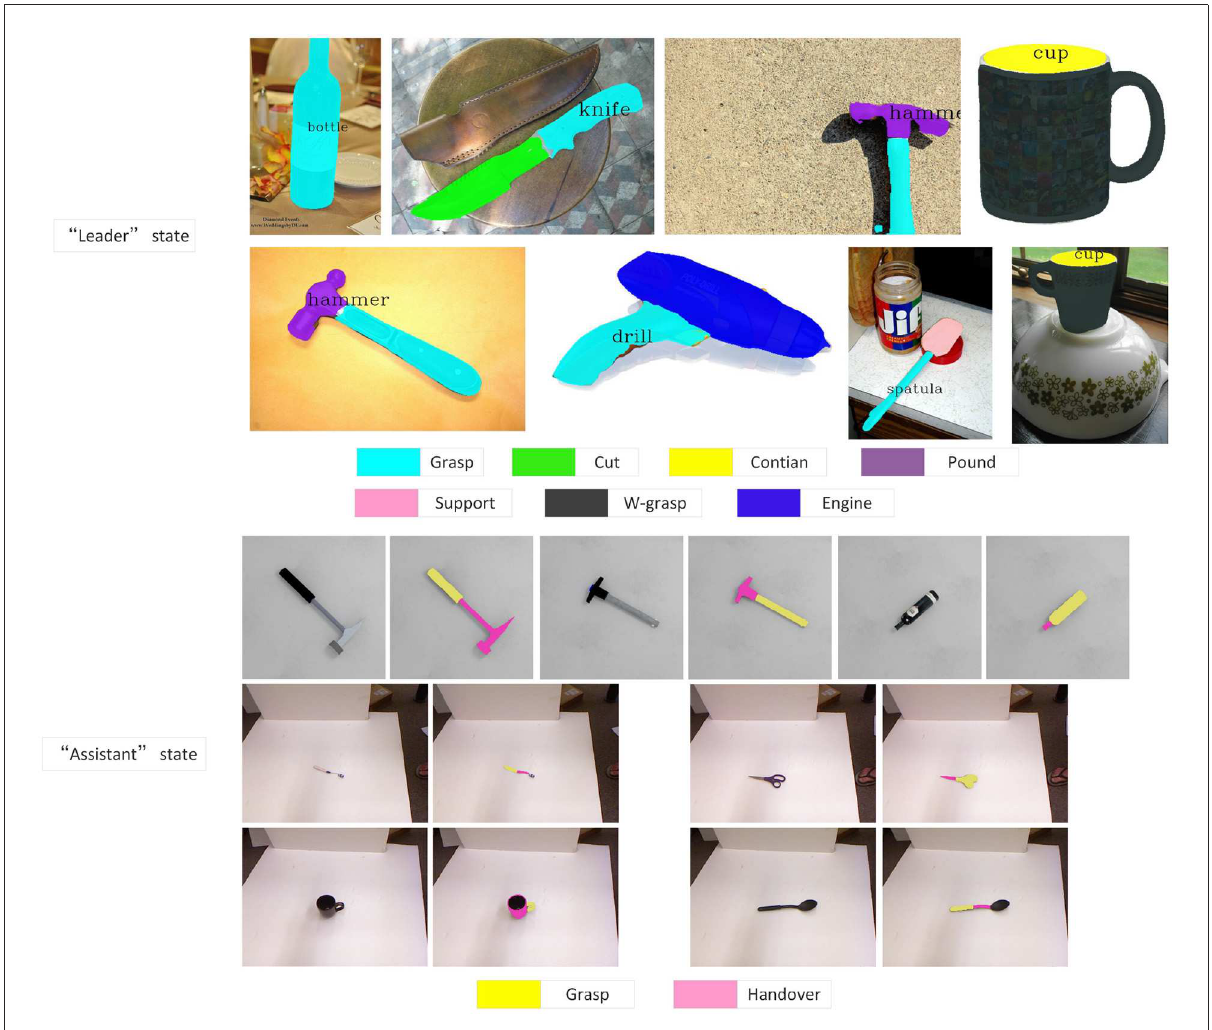
FIGURE3 Segmentation results based on “leader” and “assistant”